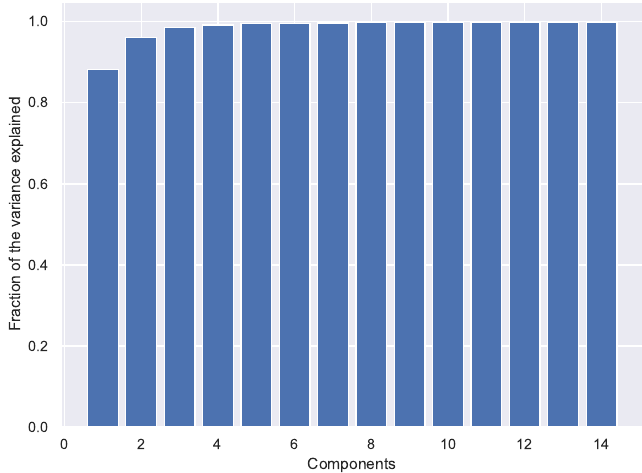
Figure 12. Fraction of the variance explained with